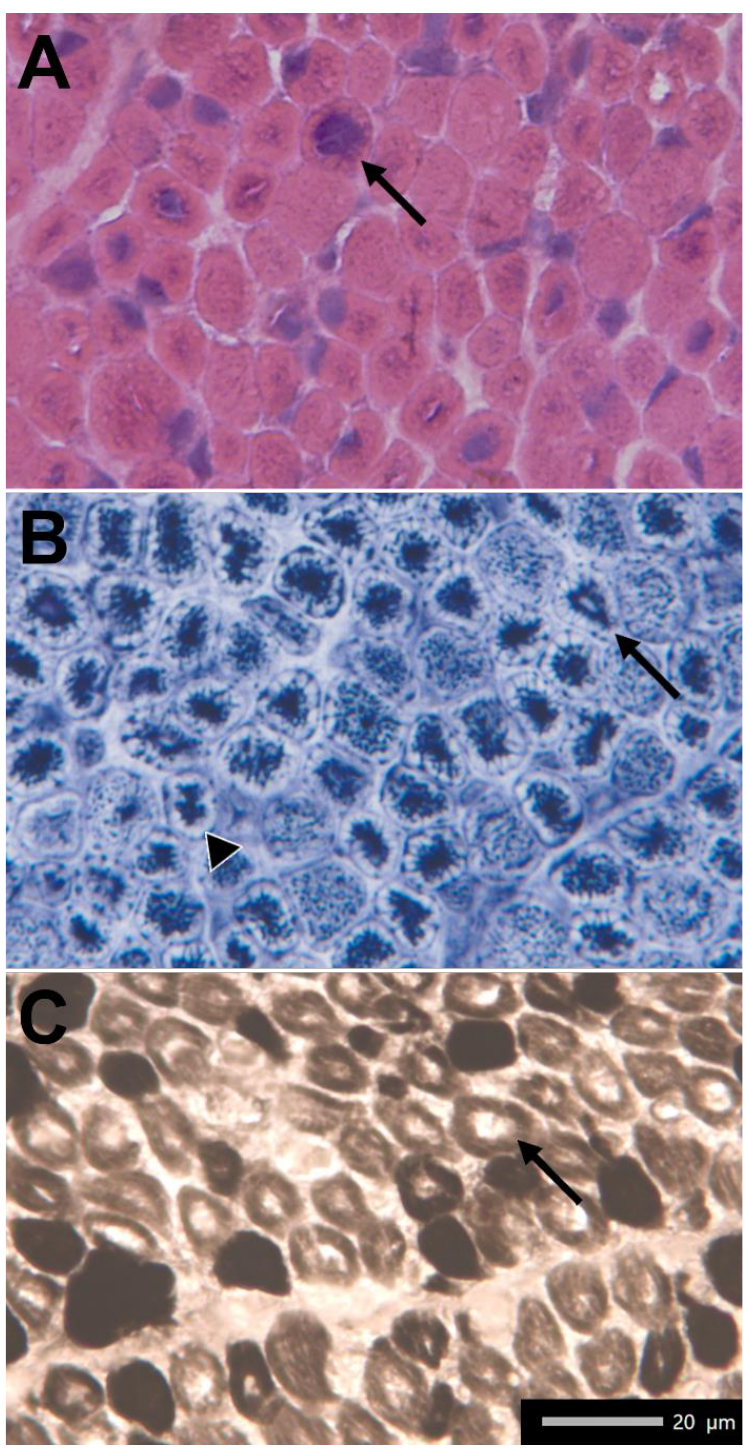
Figure 1. ( A ) Hematoxylin – Eosin. Slight increase in perimysial connective tissue. Enlarged, single central nuclei in many muscle fibers (arrow). ( B ) NADH-TR. Dark staining in the central region of many fibers with clear rim around edges (arrowhead) and perinuclear rings of mitochondria accumulation (arrow). ( C ) ATPase stain, pH 9.4. Slight predominance of type I fibers, smaller than type II, with presence of clear region in the center of many fibers (arrow).